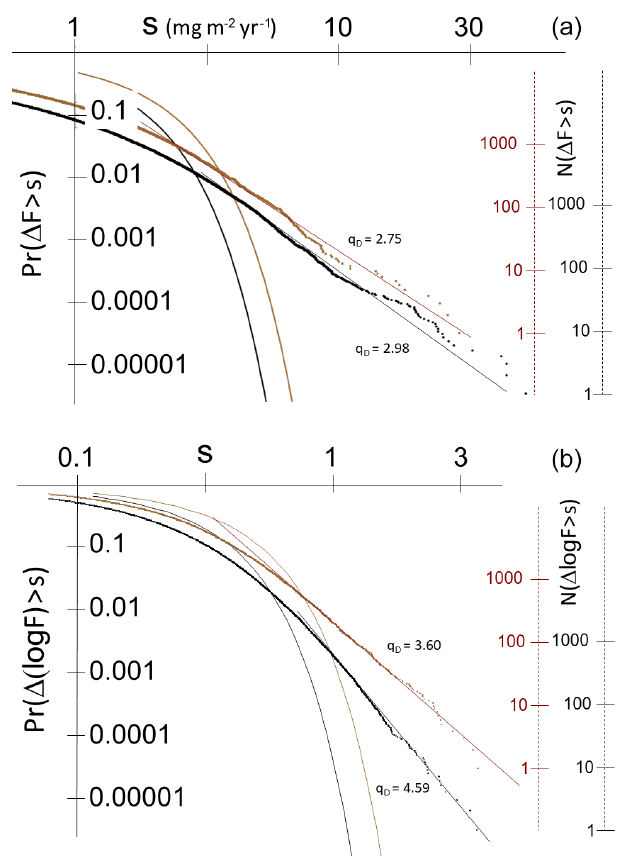
Figure 6. (a) The probability distribution Pr ( (cid:49)F > s ) of random changes in dust flux ( (cid:49)F ) exceeding a fixed threshold s in time at a 25-year resolution (brown; 32000 points) and in depth at 1cm resolution (black; 251075 points corresponding to the last 400kyr). The frequency scales on the right give the number ( N ) of jumps in each of the series that exceeds the threshold s . The straight lines indicate power law probability tails with exponents q D indicated. Also shown (parabolas) are the Gaussians with the same mean and standard deviations. In time, the maximum change in flux corre- sponds to about 28 standard deviations (i.e. to a Gauss probability ≈ 10 − 91 ); in depth, it corresponds to 51 standard deviations (i.e. to p ≈ 10 − 455 ). On the right, we provide axes giving the actual number of flux increments that exceed s (brown for the fluctuations in time; black for those in depth). (b) Same as (a) except for the increments of the log of the dust flux (brown is in time, 25-year resolution; black is in depth, 1cm resolution). The curves are the closest-fitting (log-) Gaussians. The threshold S is dimensionless, and the numerical values are correct if F is measured in units of milligrams per square metre per